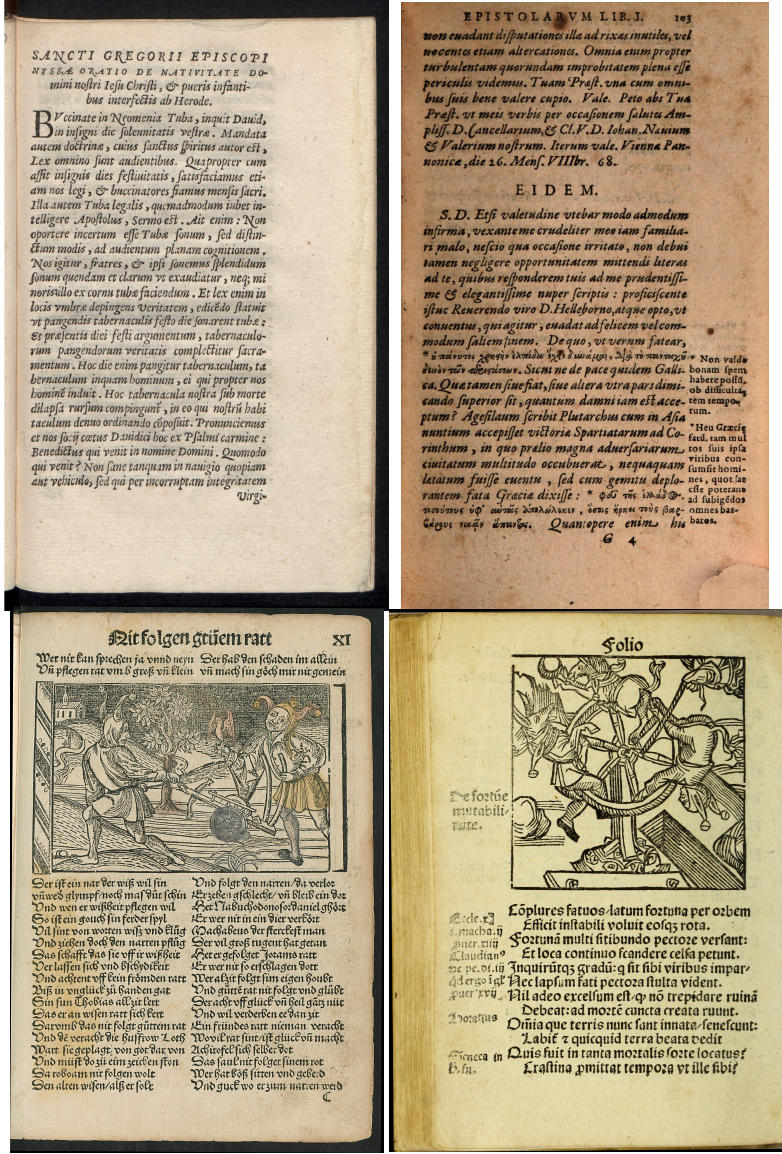
Figure 1. Example images from the datasets used. Top row (from left to right): CamStd, CamMarg; bottom row (left to right): GW5051,